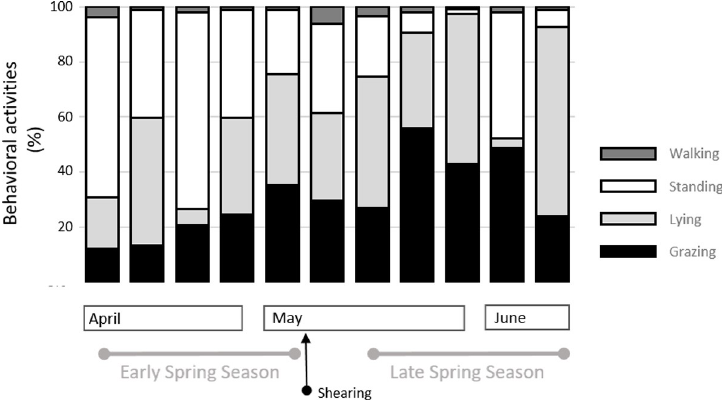
Fig 6. Weekly grazing pattern. Time–budgets of behavioural activities in 3 hr of video recording during major meals. (n = 5).